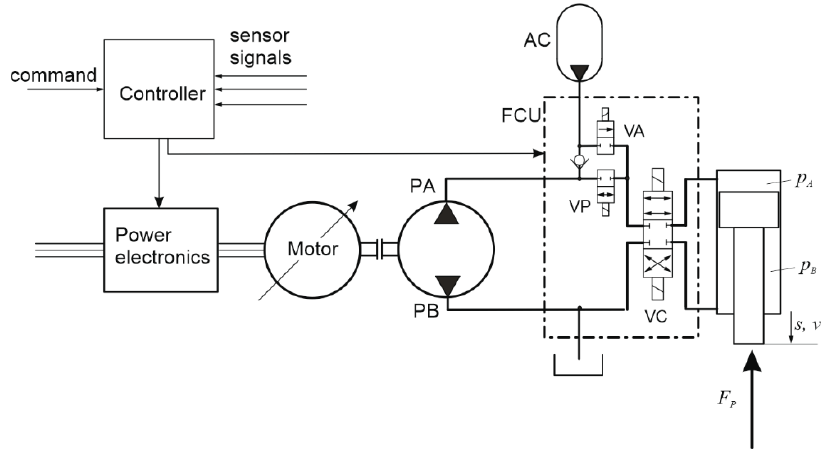
Figure 1. Basic general architecture of an electrohydraulic linear drive supplemented by a flow control unit.